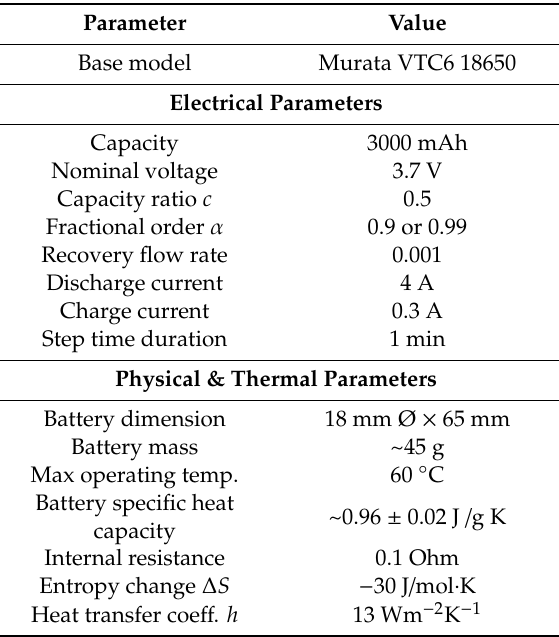
Figure 4. Battery temperature under varied discharge current, using the 18650 lithium-ion battery model described in Table 1.